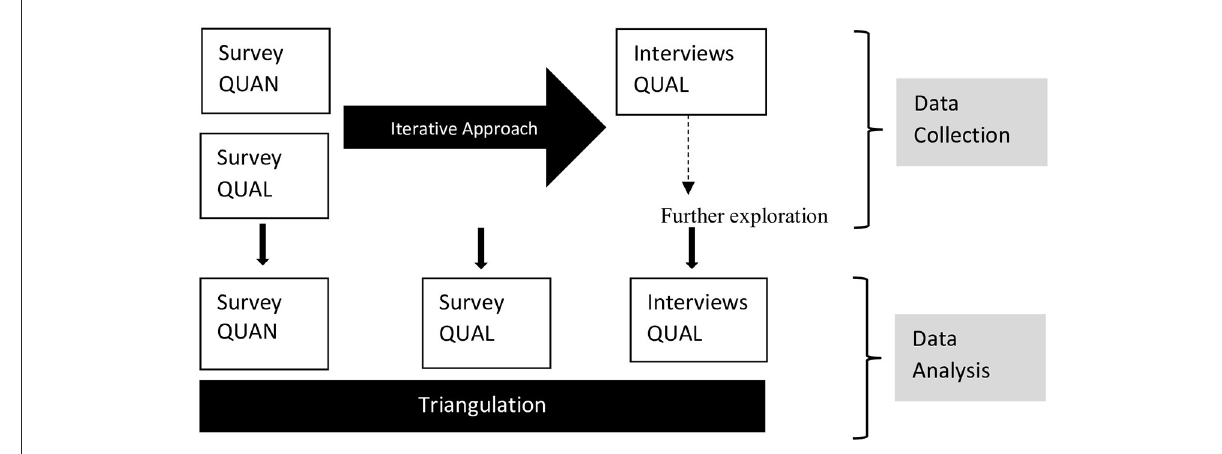
FIGURE1 Mixed methods convergent design using parallel data collection with an iterative